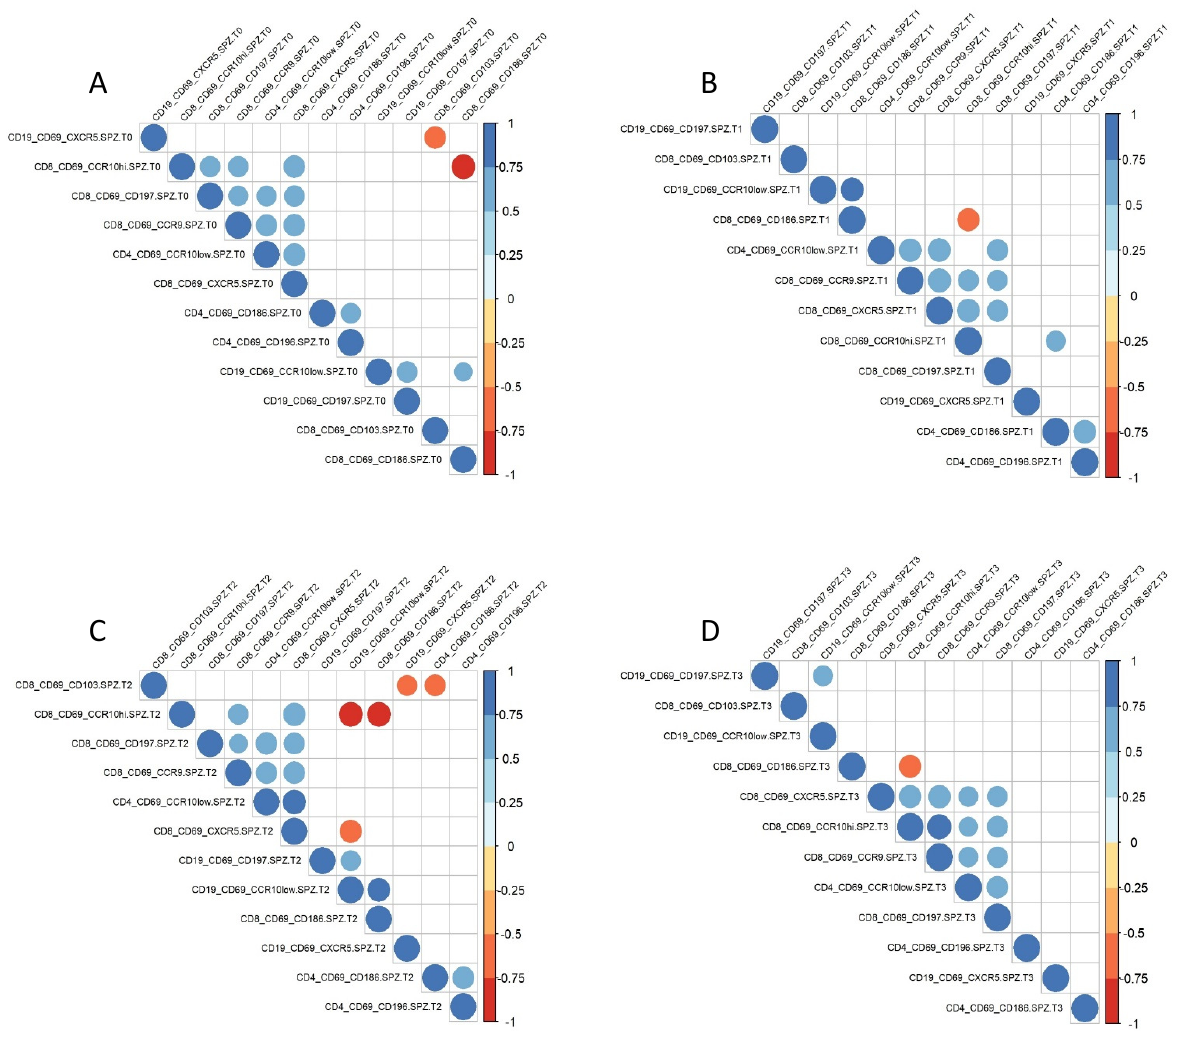
Figure 4. Homing receptor profiles induced by RAS vaccination. The relationship between expressed homing receptors on SPZ-specific lymphocytes was investigated by generating a correlation matrix including only homing receptors with significant altered expression after immunization or challenge. ( A ) Correlation matrix of these 12 parameters before immunization (T0); ( B ) after immunization (T1); ( C ) 5–6 days after CHMI (T2); ( D ) 3–4 months after CHMI (T3). Only significant correlations ( p < 0.05) are shown. The color and size of the dots (scale next to graph) indicate the degree of correlation between the different parameters (small to large indicating low to high correlation).